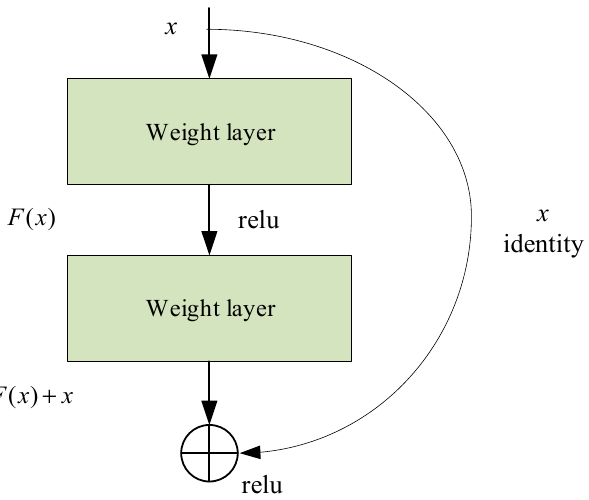
Figure 3. Residual learning module for ResNet.